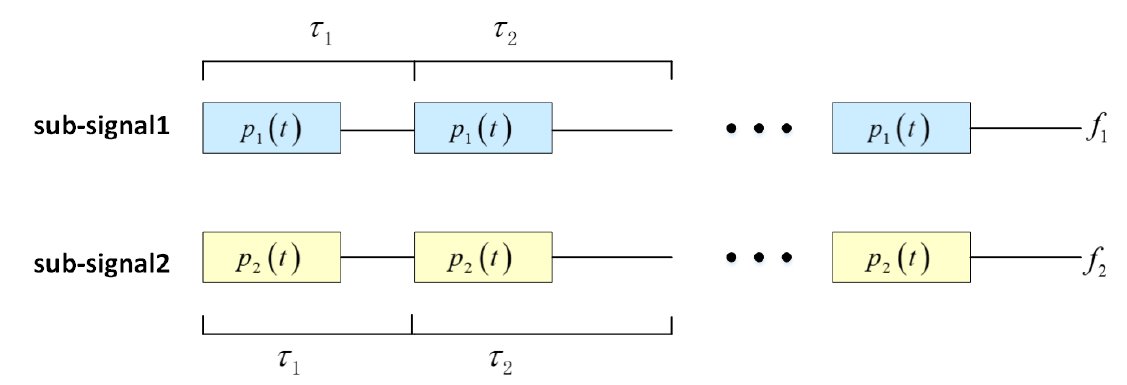
Figure 1. Structure of orthogonal combined